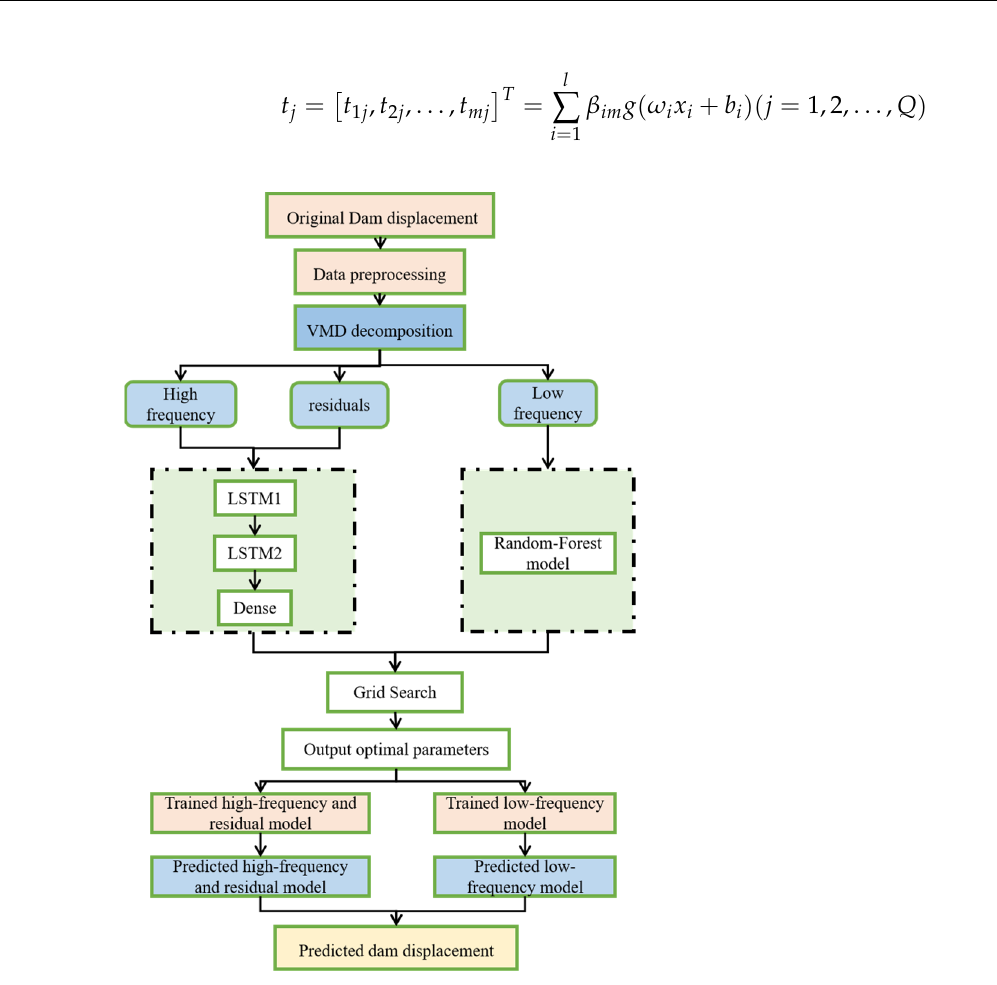
Figure 4. Flow chart of the proposed model.